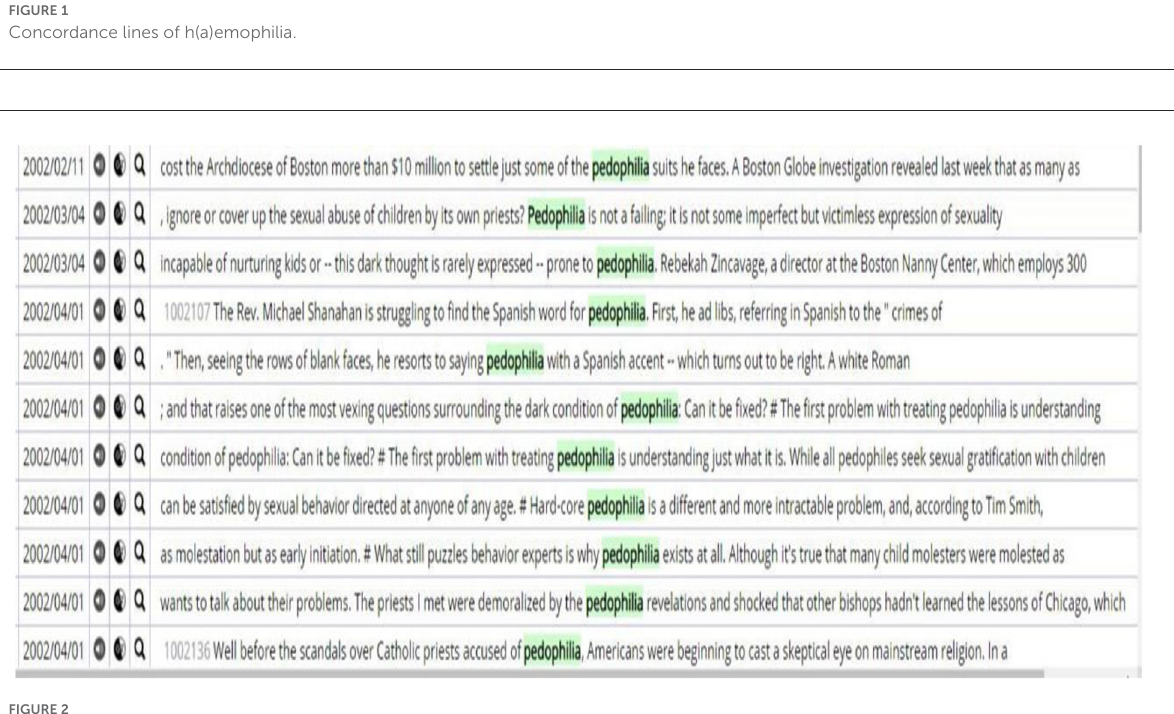
FIGURE1 Concordance lines of h(a)emophilia.